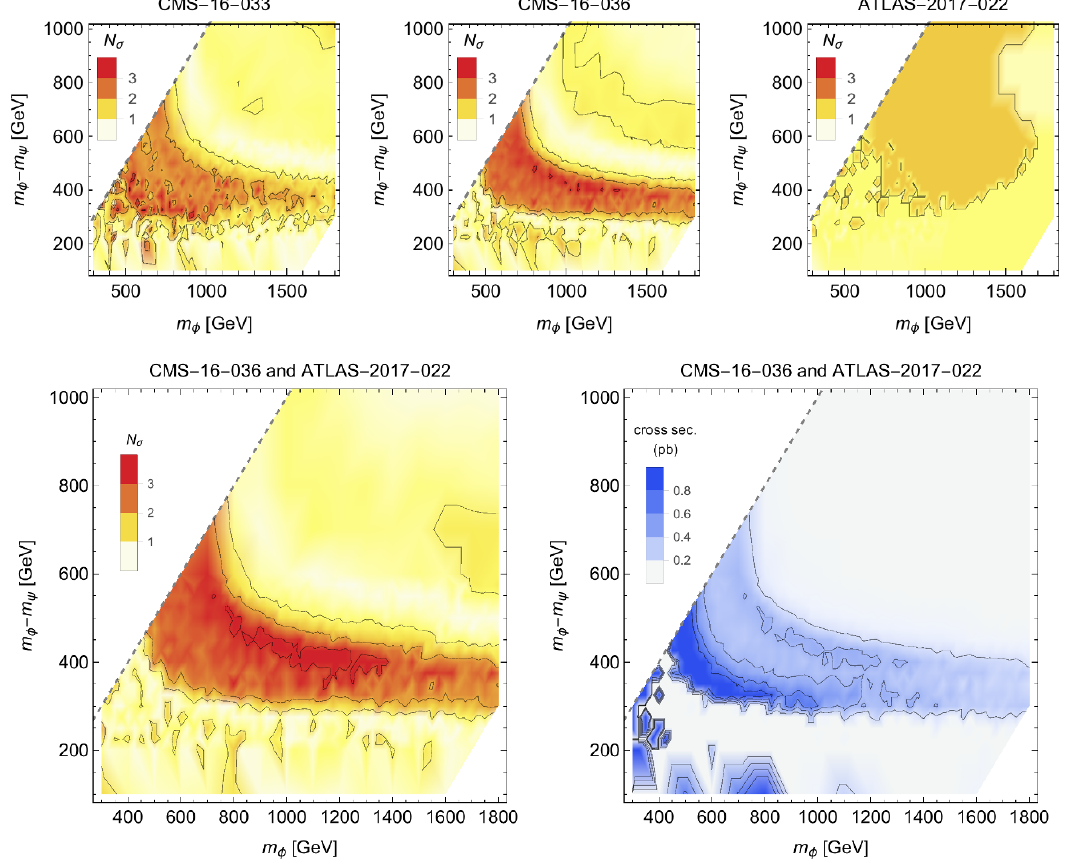
Figure 6 . Top row: signi(cid:12)cance for resonant production of (cid:30) , decaying to a jet and an invisible particle , as a function of m (cid:30) and m (cid:30) (cid:0) m , for the CMS-16-033 (left), CMS-16-036 (center), and ATLAS 2017-022 (right) analyses. The lower row shows the combined signi(cid:12)cance for ATLAS 2017-022 and CMS-16-036 (left), and the cross section corresponding to that signi(cid:12)cance